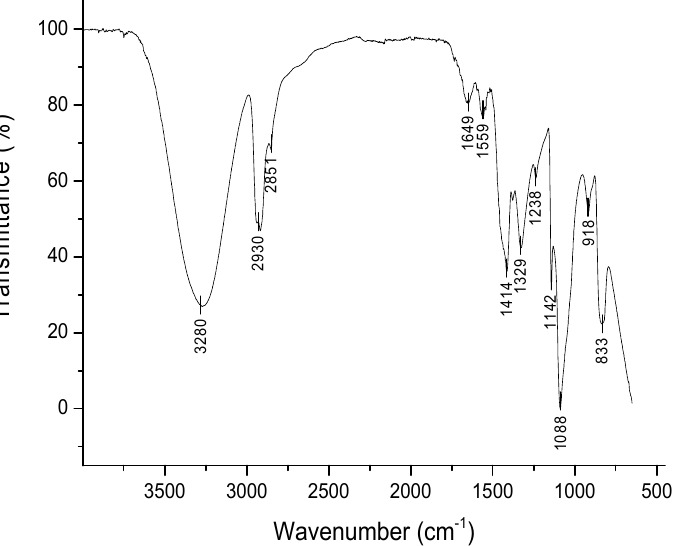
Figure 8. FTIR spectra of a PVA film produced by casting technique and irradiated with gamma rays at 25 KGy.